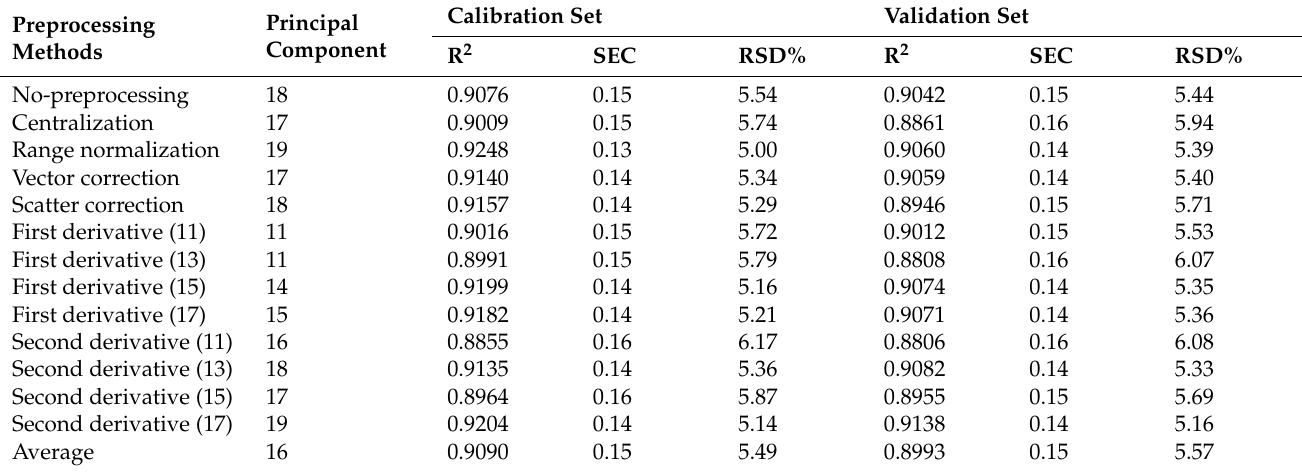
Table 7. The influence of different pretreatment and smoothing methods on NIRS prediction results